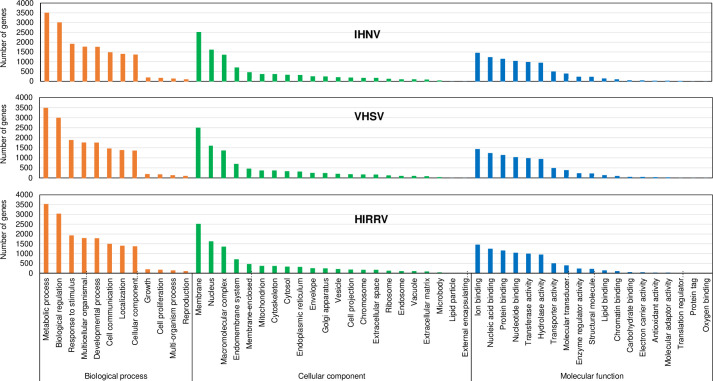
Gene Ontology (GO) categories of the unigenes.Unigenes from IHNV-, VHSV-, and HIRRV-infected HINAE cells were annotated to the 53 functional GO terms in three categories: cellular components, molecular functions, and biological process. S4 Table contains detailed information about number of genes annotated to the 53 functional GO terms.